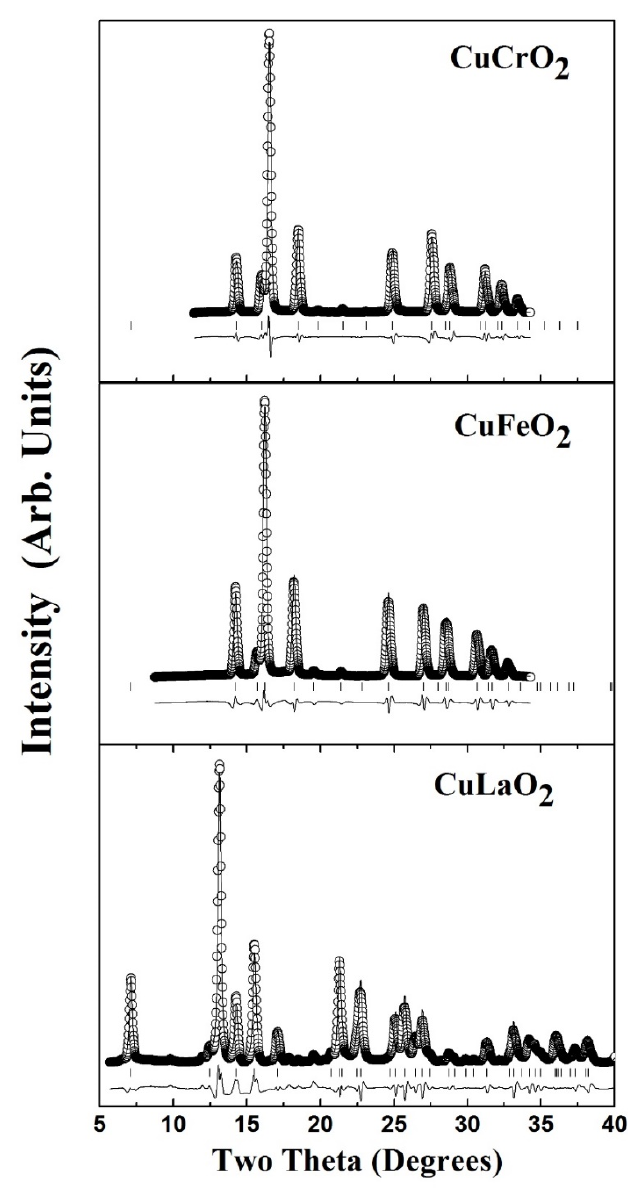
Figure 3. Rietveld refined ambient pressure and temperature X-ray diffraction patterns of as-synthesized CuLaO 2 , CuFeO 2 and CuCrO 2 showing single phase formation of the compound in rhombohedral structure. Difference plot is also plotted. Vertical tick marks represent allowed reflection of delafossite structure with R -3 m space group.